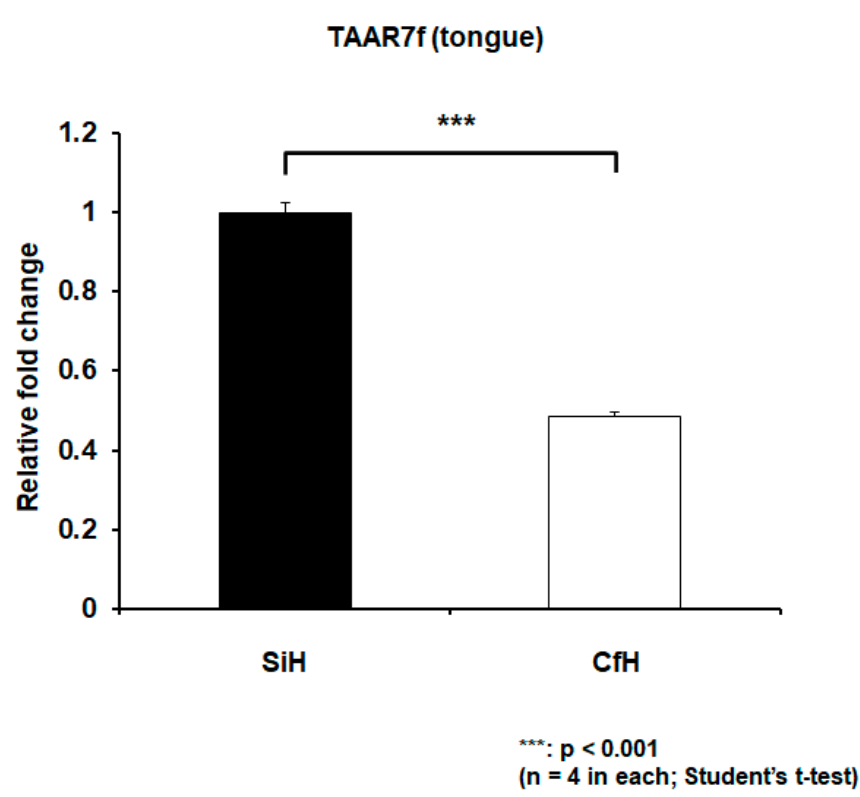
Figure 4. Gene expression of TAAR7f in tongue. ***: p < 0.001 vs. the SiH group (Student’s t -test).